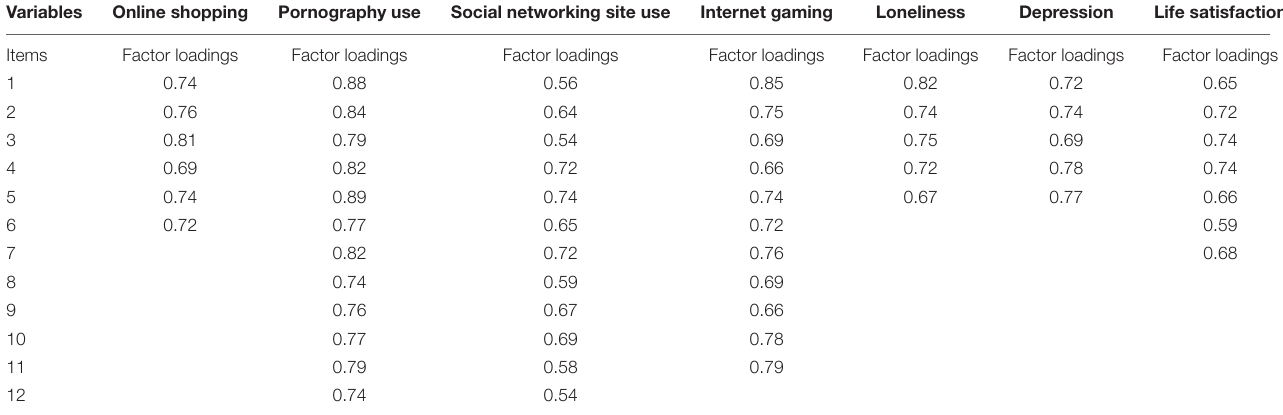
TABLE 2 | Factor loadings for online shopping, pornography use, social networking site use, Internet gaming, loneliness, depression, and life